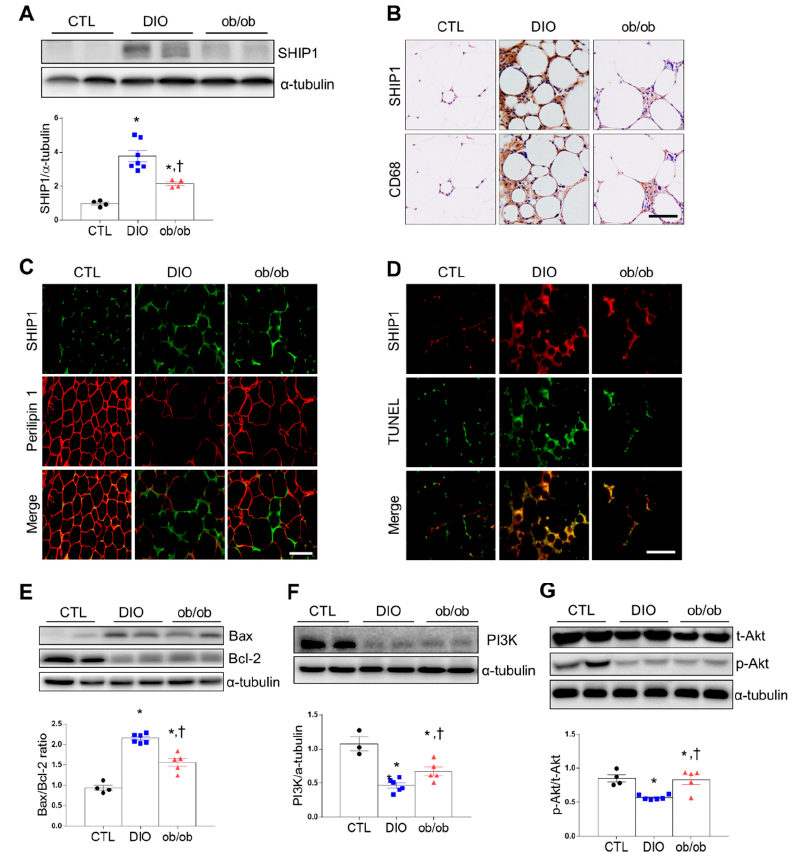
Figure 3. E ff ects of high-fat diet and leptin deficiency on inflammation and apoptosis in adipose tissue. ( A ) Western blot analysis of SHIP1 protein expression. ( B ) Representative immunostained SHIP1 and Cluster of Di ff erentiation 68 (CD68) in serial adipose tissue sections (200 × ). ( C ) Representative immunofluorescent images (200 × ) of SHIP1 (green) and perilipin 1 (red). ( D ) Representative immunofluorescent images (200 × ) of SHIP1 (red) and terminal deoxynucleotidyl transferase dUTP nick-end labeling (TUNEL) (green). ( E ) Western blot analysis of Bax and Bcl-2 protein. Graph indicates the Bax / Bcl-2 ratio. ( F , G ) Western blot analysis of phosphoinositide 3-kinase (PI3K),total protein kinase B (t-Akt), and phosphorylated Akt (p-Akt) protein expression, using α - tubulin as a reference protein. Data are presented as the means ± SEM. * p < 0.05 versus CTL mice; † p < 0.05 versus DIO mice. Scale bar = 50 μ m. CTL (black circle), DIO (blue square), ob/ob (red triangle).